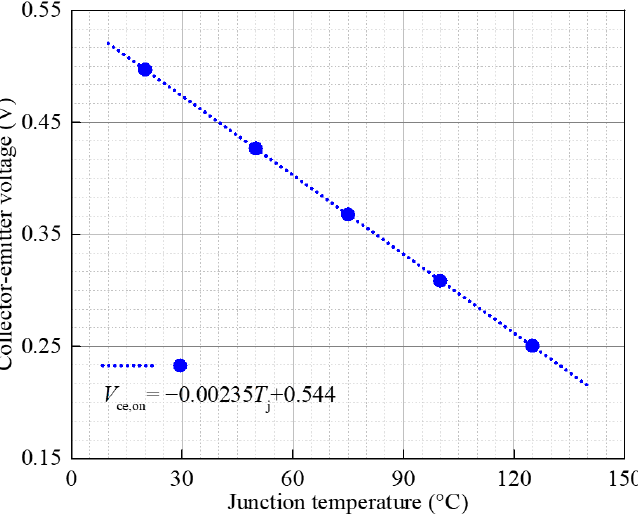
Figure 4. The calibration curve of the V ce-on and T j of the IGBT module. Then, the T3Ster thermal resistance tester is used to measure the transient thermal impedance curve of the IGBT module. The configuration of the transient thermal impedance curve measurement is shown in Figure 5. When the transient thermal impedance curve test starts, a heating current of 100 A flows through the DUT for a heating time of 200 s. The IGBT module is heated to thermal equilibrium, the heating current is turned off, and water cooling is started. At this time, the test current is applied to the circuit to measure the V ce-on of the DUT in the cooling stage, and the sampling interval is 1 µ s. The T j ( t )